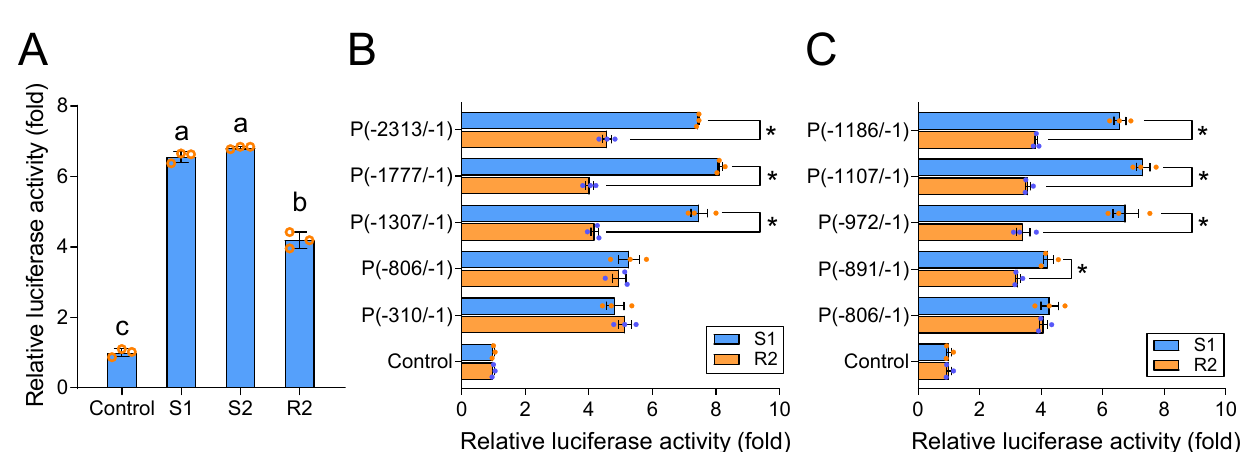
Figure 2. Detection of promoter activity by dual luciferase reporter assay. ( A ) Analysis of the activity of the primary PxABCG1 resistance promoter (R2) and the main PxABCG1 susceptibility promoter (wild-type S1/S2). The relative luciferase activity (firefly luciferase activity/ Renilla luciferase activity) of different pGL4.10-promoter plasmids was normalized to that of the control pGL4.10 vector. The values shown are the means and the corresponding standard error of the mean (SEM) values for three biological replicates and four technical replicates. The significance of differences was determined by one-way ANOVA with Duncan’s test ( p < 0.05). Different letters on the bars indicate significant differences. ( B ) Activity of progressive 5 (cid:48) deleted recombinants of the S1 and R2 promoters after shortening from − 2313 to − 310. Student’s t-test was used for statistical analysis (*, p < 0.05). ( C ) Activity of progressive 5 (cid:48) deletion constructs created through shortening of the sequence from − 1186 to − 806. Student’s t-test was used for statistical analysis (*, p <